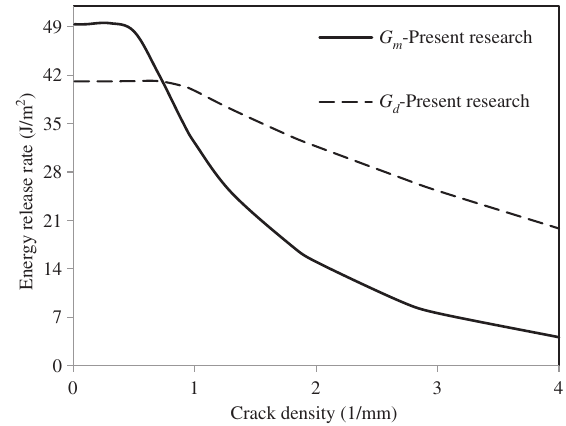
] s carbon/ 2 = 10 MPa. 2